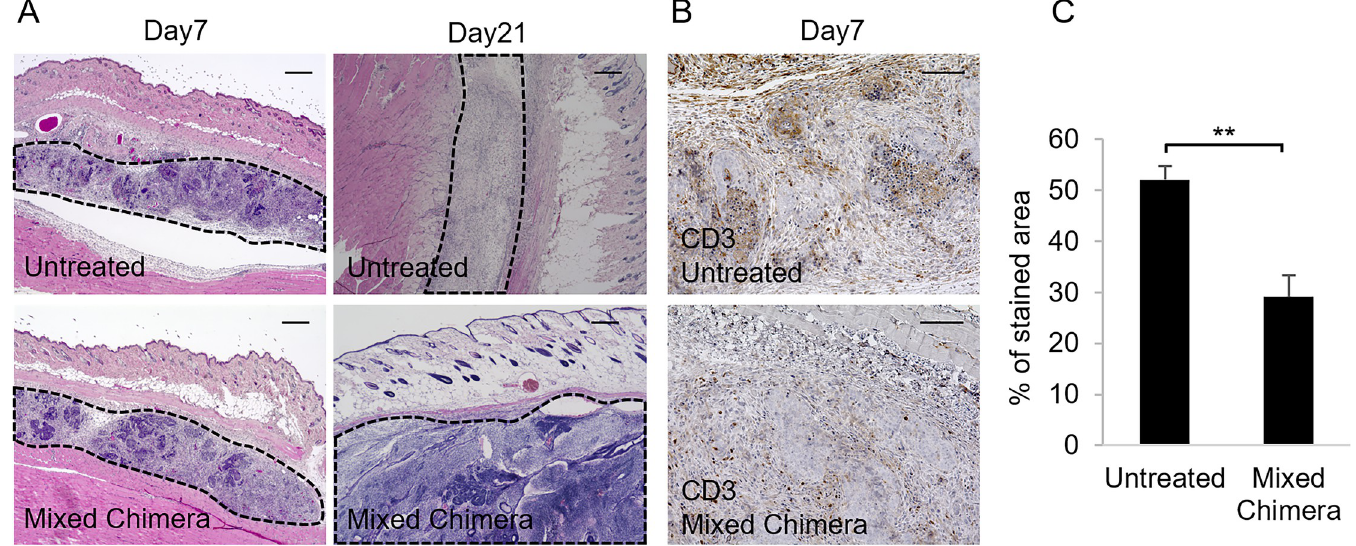
Fig 4. Histochemical and immunohistochemical staining of tissue sections. (A) Representative images showing hematoxylin and eosin staining of tissue sections from normal untreated BALB/c mice ( top ) or mixed-chimera BALB/c mice ( bottom ) 7 days ( left ) and 21 days ( rignt ) post transplantation. Dotted lines indicate surviving induced pluripotent stem cell-derived cardiomyocyte (iPSC-CM) sheets or transplanted site. Scale bar, 300 μ m. (B) Representative immunohistochemical staining images using an anti-CD3 antibody for normal untreated BALB/c mice ( top ) or mixed-chimera BALB/c mice ( bottom ) 7 days post transplantation. Scale bar: 100 μ m. (C) The percentages of stained area for CD3 in untreated BALB/c and mixed-chimera BALB/c mice. Student’s t -test was performed, and the results are depicted as mean ± SEM. �� P < 0.01.